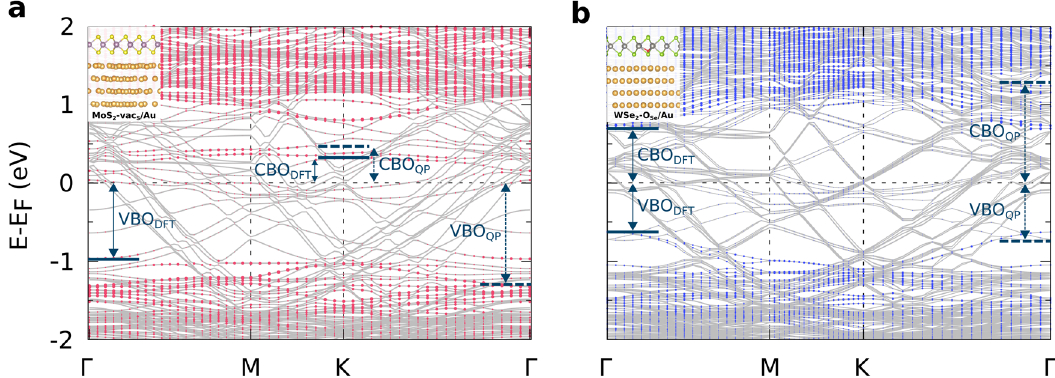
Fig. 3 DFT band structures of TMDC/metal junctions with common point defects. a MoS 2 -vac S /Au and ( b ) WSe 2 -O Se /Au. Projections onto Mo/S and W/Se orbitals are shown as red and blue circles, respectively. The size of the circles is proportional to the weight of the orbital projection. The band structure in ( b ) includes the effect of spin orbit coupling (SOC). The DFT valence band offsets (VBO) and conduction band offsets (CBO) are indicated. The quasiparticle (QP) VBO and CBO, obtained from separate GW calculations, are also indicated. Energies are referenced to the Fermi level, E F . Atomic structures are shown as insets: Au (gold); Mo (purple); S (yellow); W (grey); Se (green); O